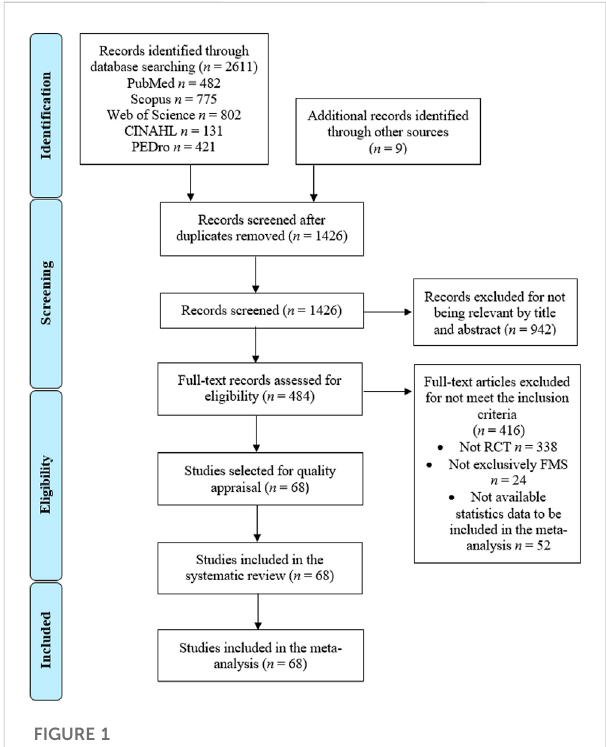
FIGURE 1 PRISMA Flow Diagram from selection of the